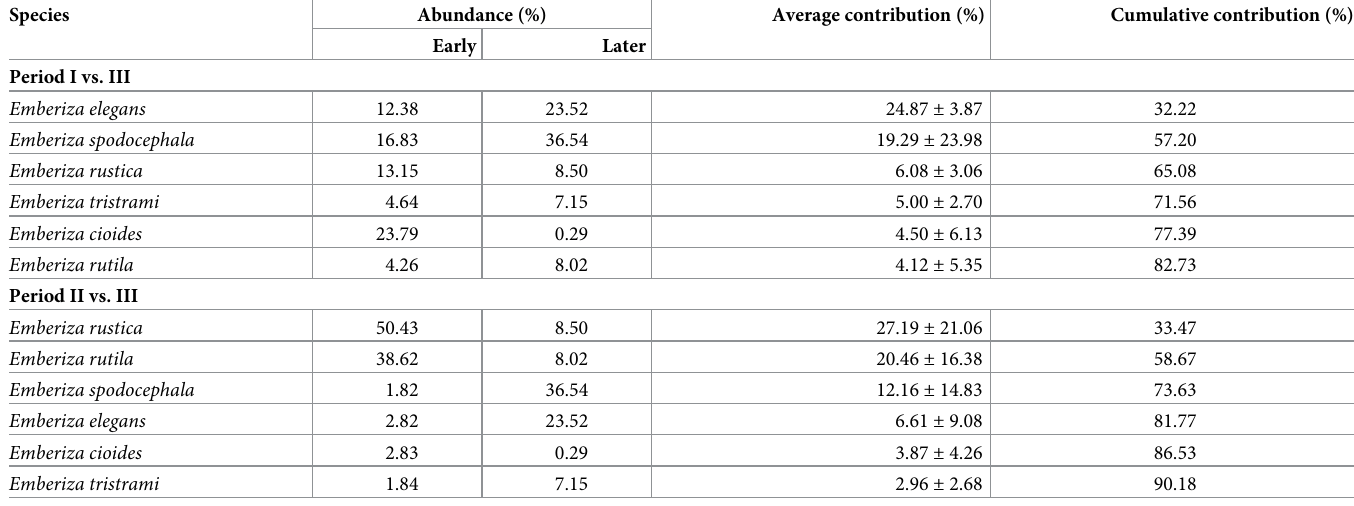
Table 3. The pairwise comparison of Emberiza bunting communities from the combined museum collection and bird banding data in Korea. Average abundance (%) in each period, average contribution to overall Bray–Curtis dissimilarity (%) with its standard deviation, and ordered cumulative contributions of six top species were given. The average contribution indicates the species contribution to average between-group dissimilarity. Cumulative contributions are based on the average contribu- tions, but they are standardized to sum up to total 100.